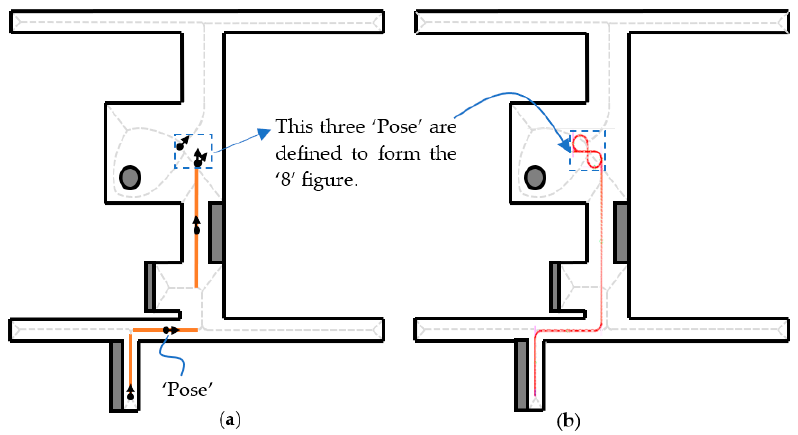
Figure 10. Path planning using Sidomotion ( a ) pose information; ( b ) designed path according to the pose information.